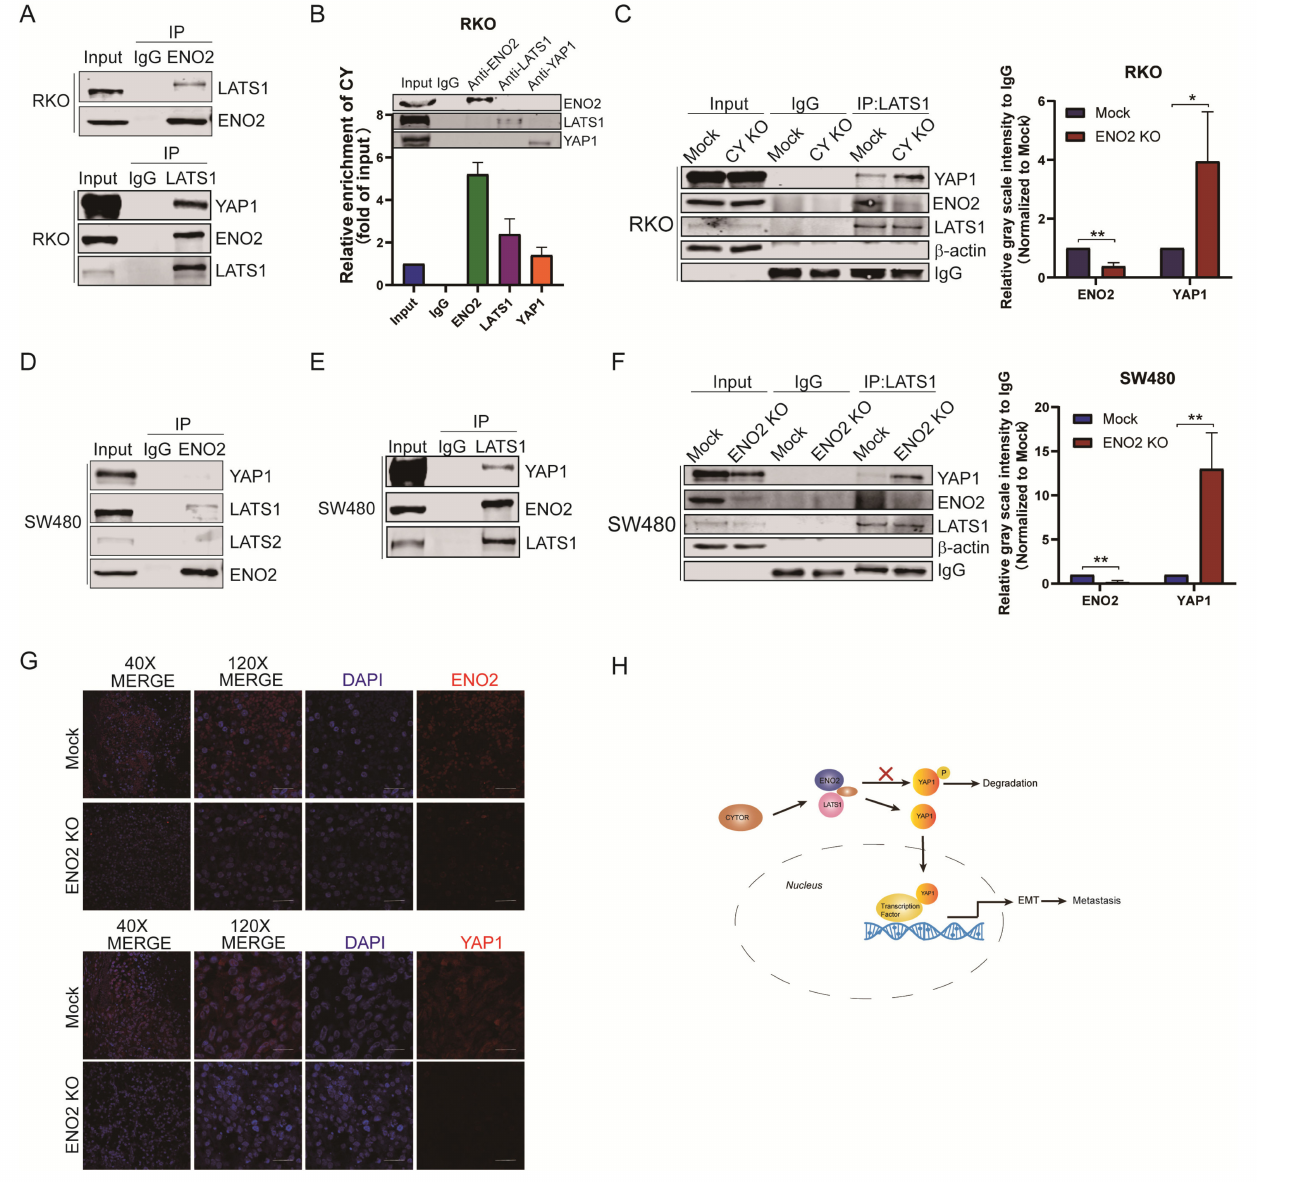
Figure 6. CYTOR mediated ENO2 binding to LATS1 and inhibited the degradation of YAP1. ( A ): Co-IP assay of anti-LATS1 in RKO cells. ( B ): RIP assay of CYTOR with anti-ENO2, anti-LATS1 and anti-YAP1 in RKO cells. (C ): Co-IP assay of anti-LATS1 in RKO mock/RKO CYTOR KO cells. ( D , E ): Co-IP assay of anti-ENO2 ( left ) and anti-LATS1 ( right ) in SW480 cells. ( F ): KO of ENO2 significantly enhanced the binding between LATS1 and YAP1. ( G ): Immunohistochemical staining revealed the differences in ENO2 and YAP1 expression in implanted orthotopic splenic tumors from the two groups (magnification, 200 × ). ( H ): Schematic representation of the ENO2 signal transduction pathway in CRC. Data are shown as the mean ± SD. * p < 0.05, ** p <